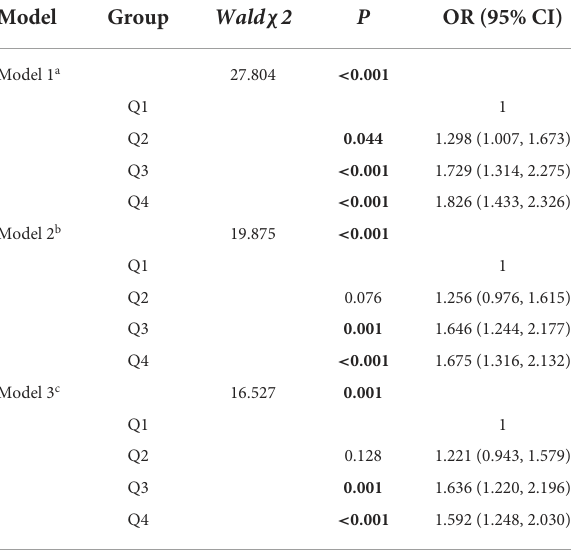
TABLE 2 Logistic regression analysis of DII and metabolic